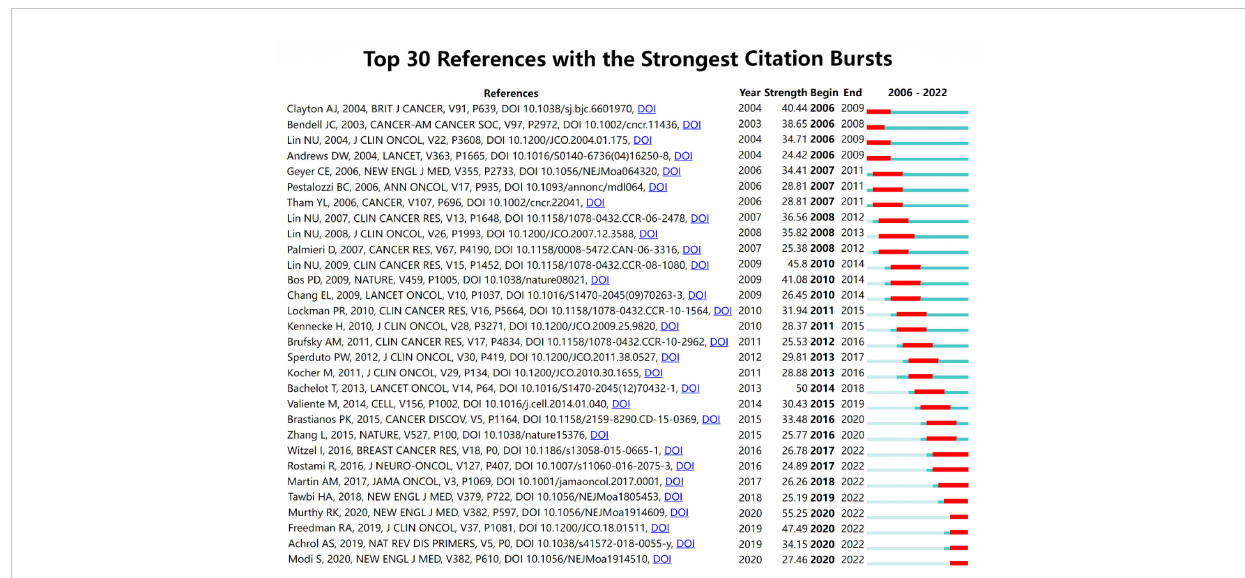
FIGURE 9 Top 30 references with the strongest citation bursts. The blue line re fl ects the duration of the citation of the paper. The red segment re fl ects the duration of the burst.